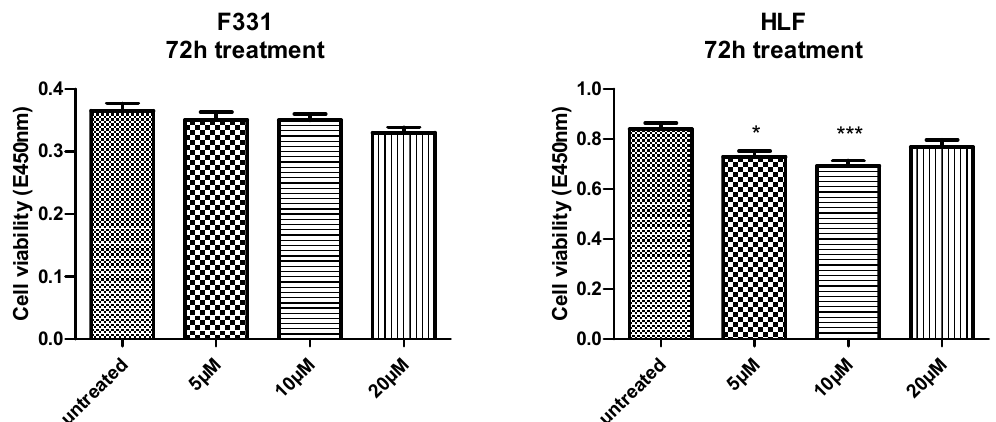
Figure 3. Toxicological profile of compound 5b was examined on two fibroblast cell lines, as relative rapidly proliferating non-tumor human cells. Result of the MTT assay after exposure to 5b for 72 hours, no significant difference in cell growth in F331, some inhibitory activity could be statistically speculated for 10 µM at HLF, but not for 20 µM. Significance was designated as * for P < 0.05 and *** for P < 0.001. Error bars depict ± SD.